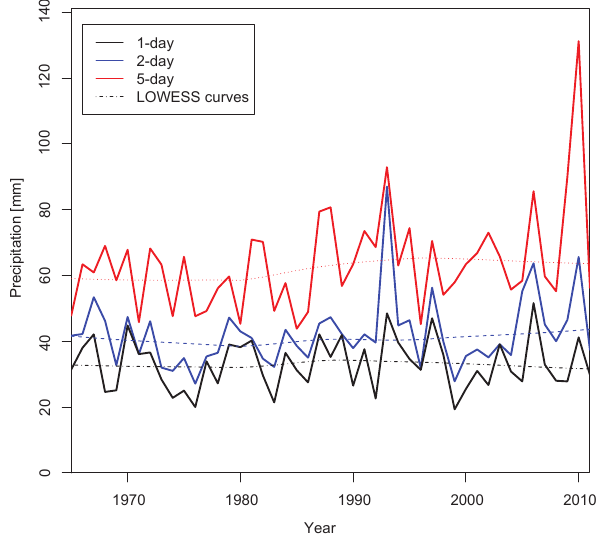
Figure 10. Analysis of 1-, 2- and 5-day maximum precipitation based on data from the local meteorological station Granja Kayra (Cusco) between 1965 and 2011. Trends are calculated using a lo- cally weighted polynomial regression (LOWESS) and indicate min- imum changes in 1-day and 2-day maximum precipitation, and a moderate increase of 5-day maximum precipitation in the 1980s with a stabilization on a higher level since